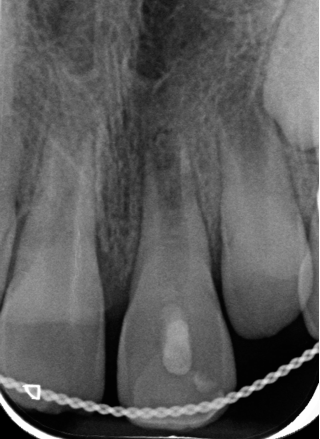
Figure 3. Case 1, one month following avulsion. Radiographs exhibited initial evidence of inflammatory resorption. Clinically, a metal sound in percussion with no detectable mobility suggested the tooth was ankylotic.